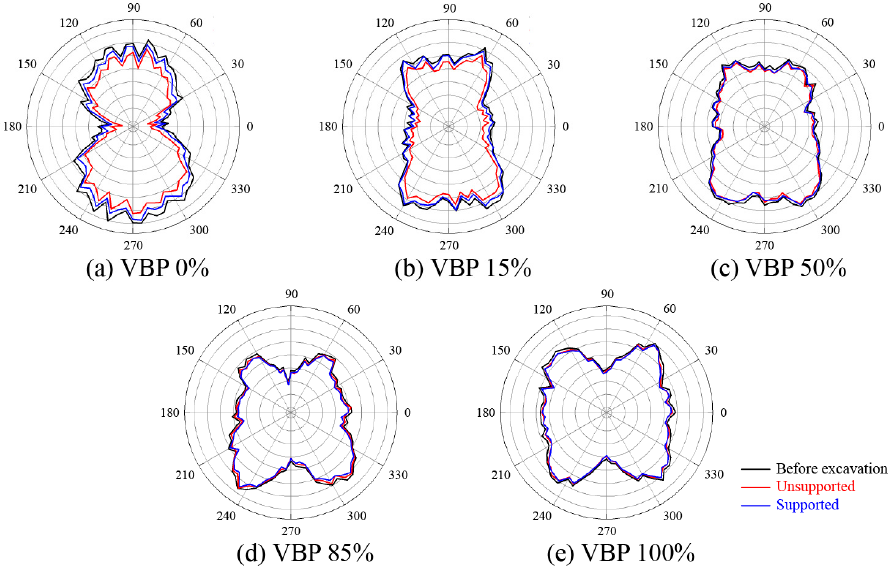
Figure 9. The number of contacts with the same normal vector in each direction within the whole computational domain of VBP = ( a ) 0%, ( b ) 15%, ( c ) 50%, ( d ) 85% and ( e )